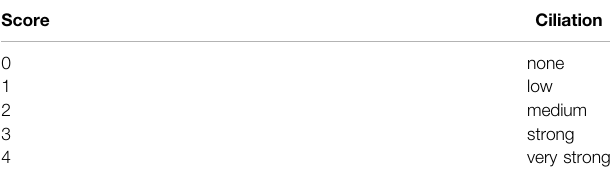
TABLE 1 | Ciliation scoring